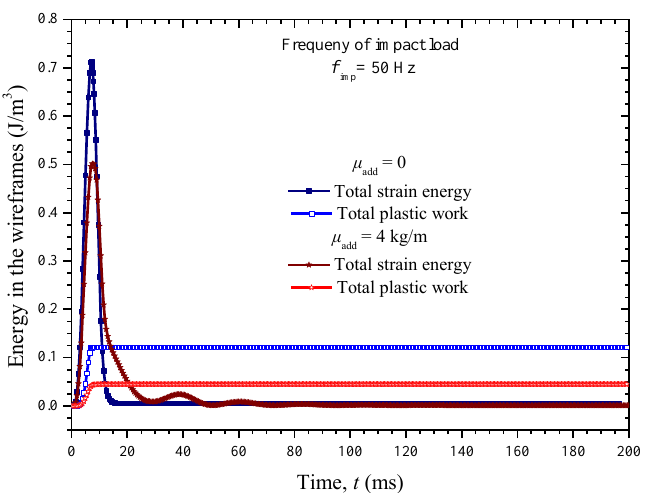
Figure 13. Time variation of both the total strain energy and plastic deformation work in the wireframes under a 50 Hz half-sine impact shock, for zero and 4 kg/m mass addition around the flywheel perimeter.